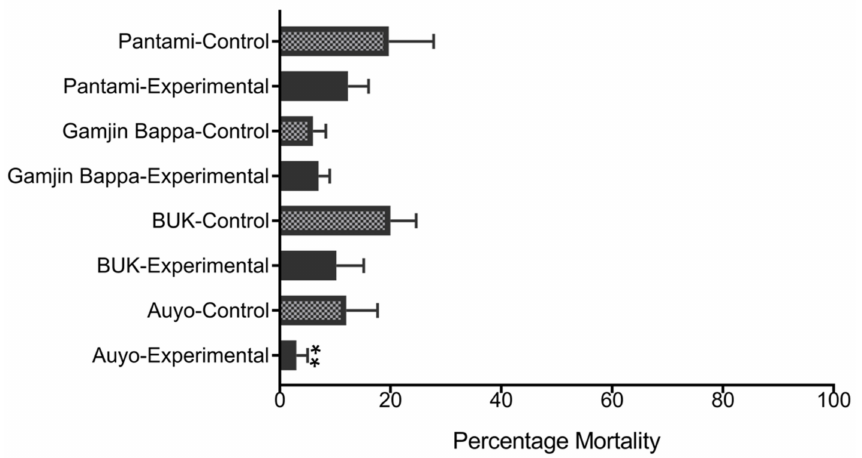
Figure 3. Result of susceptibility bioassay using heat-hardened and control adult An. gambiae s.l. females. WHO bioassays with 0.75% permethrin. ** = significantly different from the control at p <